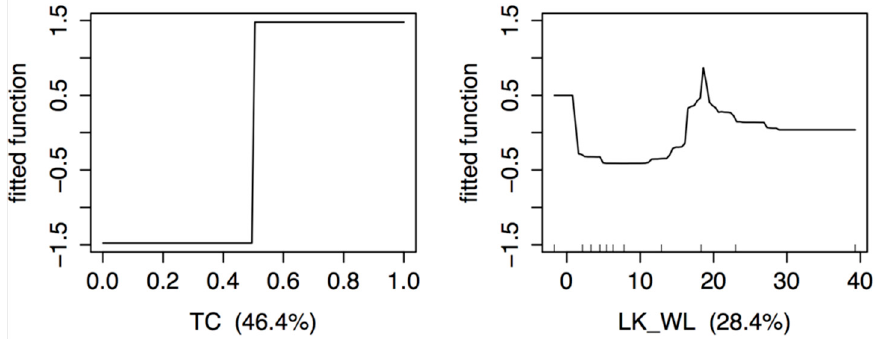
Figure 5. Results of boosted regression tree (BRT) analysis explaining the environmental drivers of CDOM in Central Yamal lakes. Number of plots decreased down to 2, showing the most important drivers. The percentage represents the degree of variable impact for the explanation of CDOM differences. The behavior of the line creates peaks and groups of lakes with higher and lower concentration of CDOM.